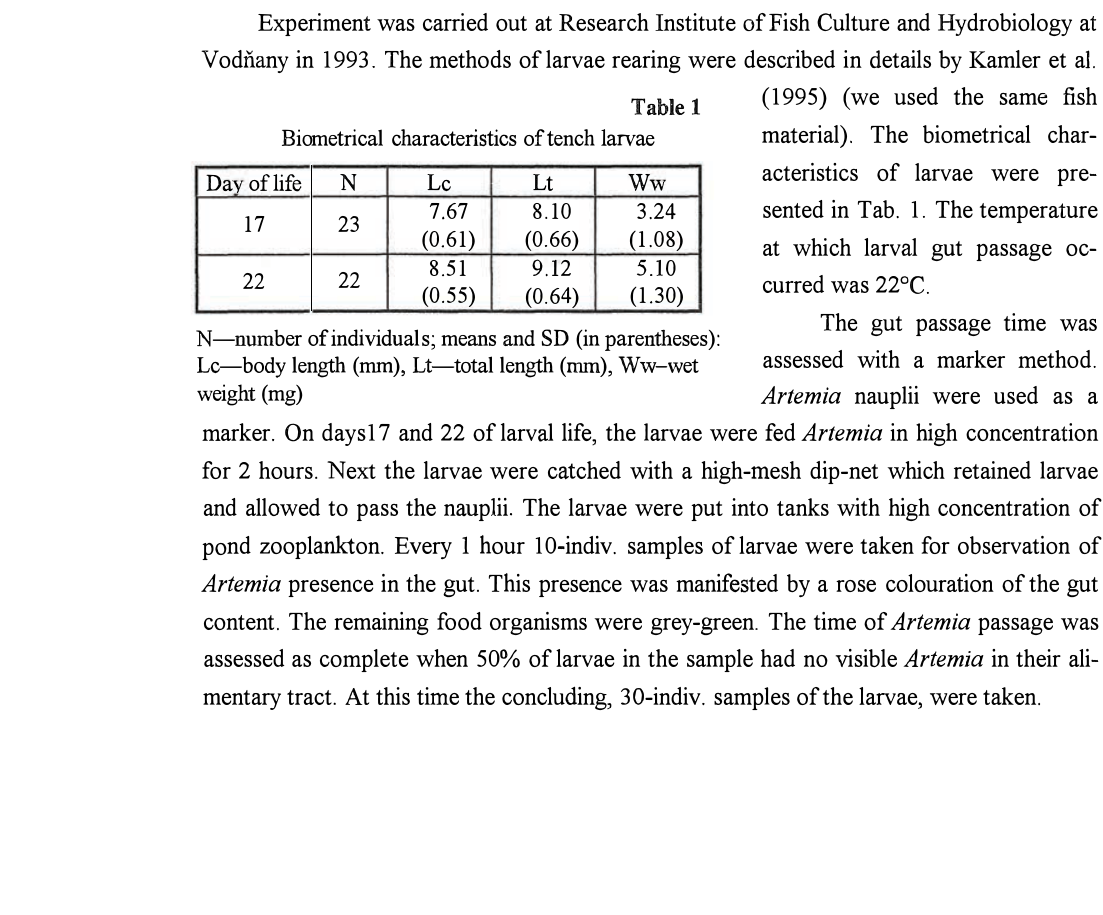
1 (1995) (we used the same